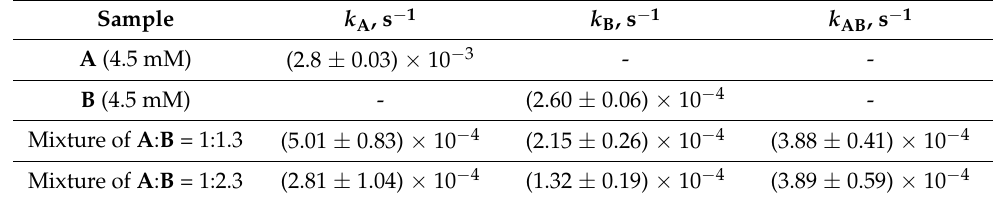
Table 1. Kinetic constants of photodimerization of anthracene ( A ) and 9-bromoanthracene ( B ) in separate samples and in the mixtures. Values k A , k B and k AB were calculated using a fitting procedure for the first 6000 s and correspond to reactions A + A → AA , B + B → BB , A + B → AB , respectively. Sample k A , s − 1 k B , s − 1 k AB , s − 1 A (4.5 mM) (2.8 ± 0.03) × 10 − 3 - - B (4.5 mM) - (2.60 ± 0.06) × 10 − 4 - Mixture of A : B = 1:1.3 (5.01 ± 0.83) × 10 − 4 (2.15 ± 0.26) × 10 − 4 (3.88 ± 0.41) × 10 − 4 Mixture of A : B = 1:2.3 (2.81 ± 1.04) × 10 − 4 (3.89 ± 0.59) × 10 −